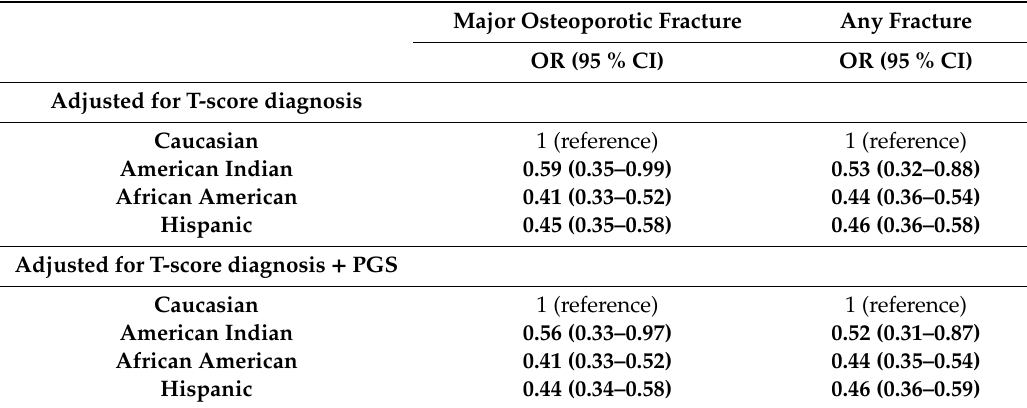
Table 3. Hazard Ratios (HR) with 95% Confidence Interval (CI) for Outcomes of Incidence Fracture According to Race Group, adjusted for T-score diagnosis, and Polygenic Score Groups: Results from Cox Proportional Hazard